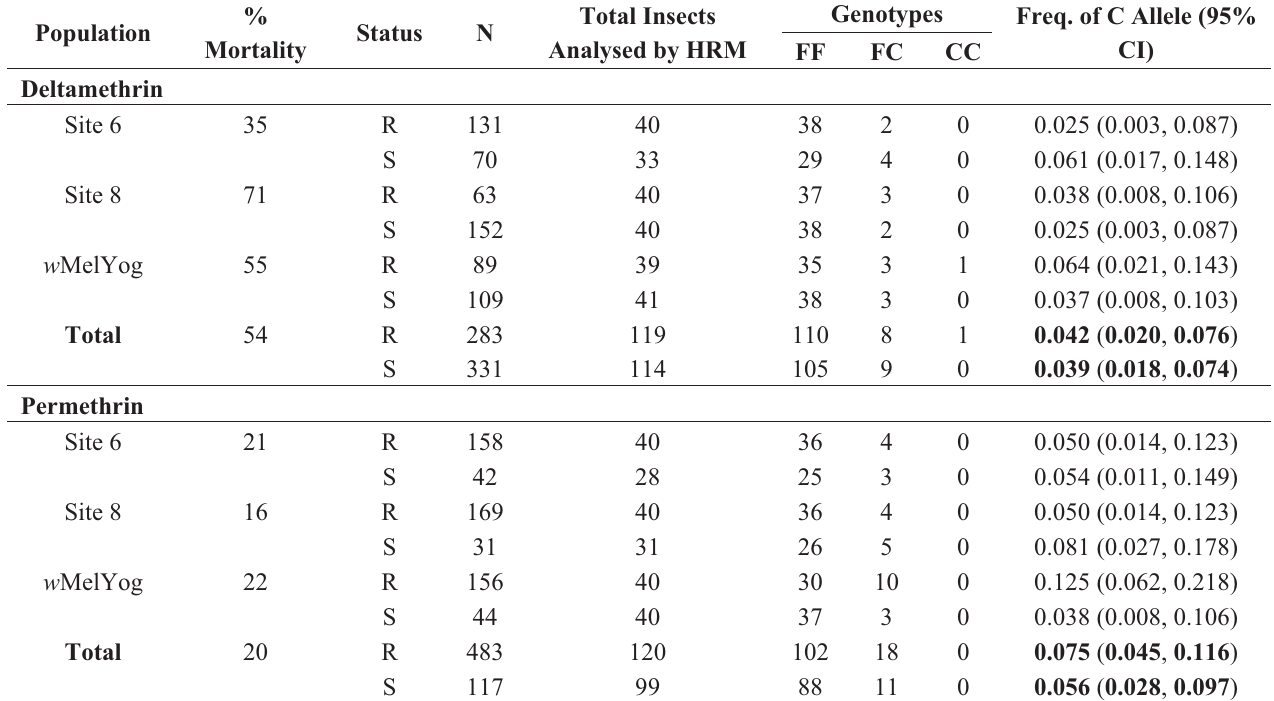
Table 4. Genotypes and allele frequencies of Vssc mutation F1565C in Aedes aegypti mosquito samples from Yogyakarta (Site 6, Site 8 and w MelYog) assayed with deltamethrin and permethrin.